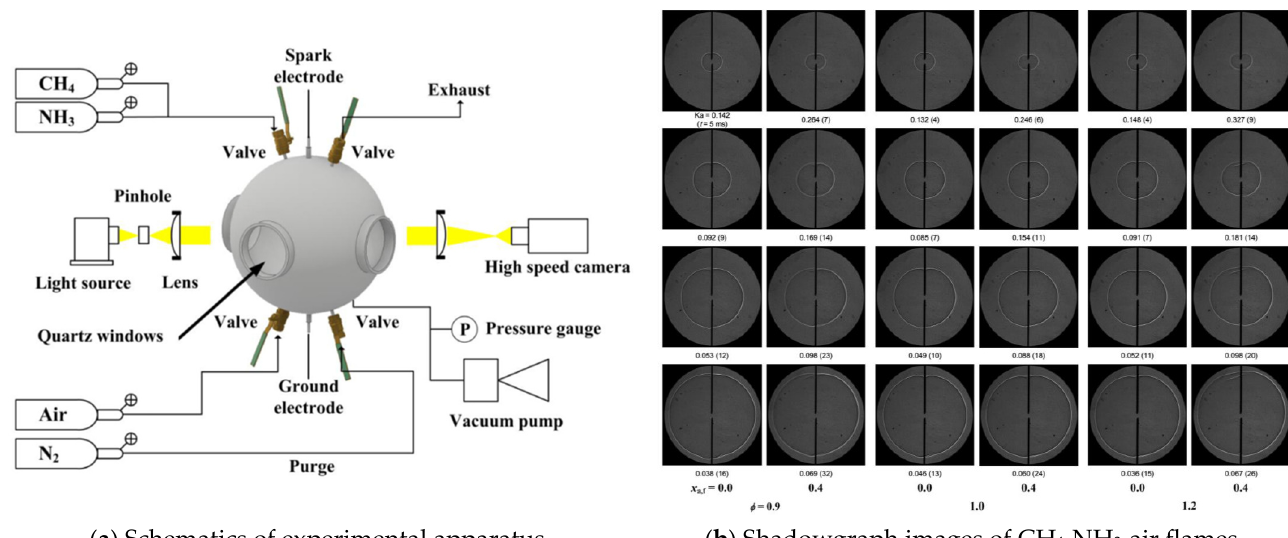
Figure 10. Equipment and results for measurement of combustion characteristics of CH 4 -NH 3 -air flames according to NH 3 co-combustion ratio: ( a ) Schematics of experimental apparatus; ( b ) Shadowgraph images of premixed CH 4 -NH 3 -air flames at normal temperature and pressure. Courtesy of Elsevier [64].